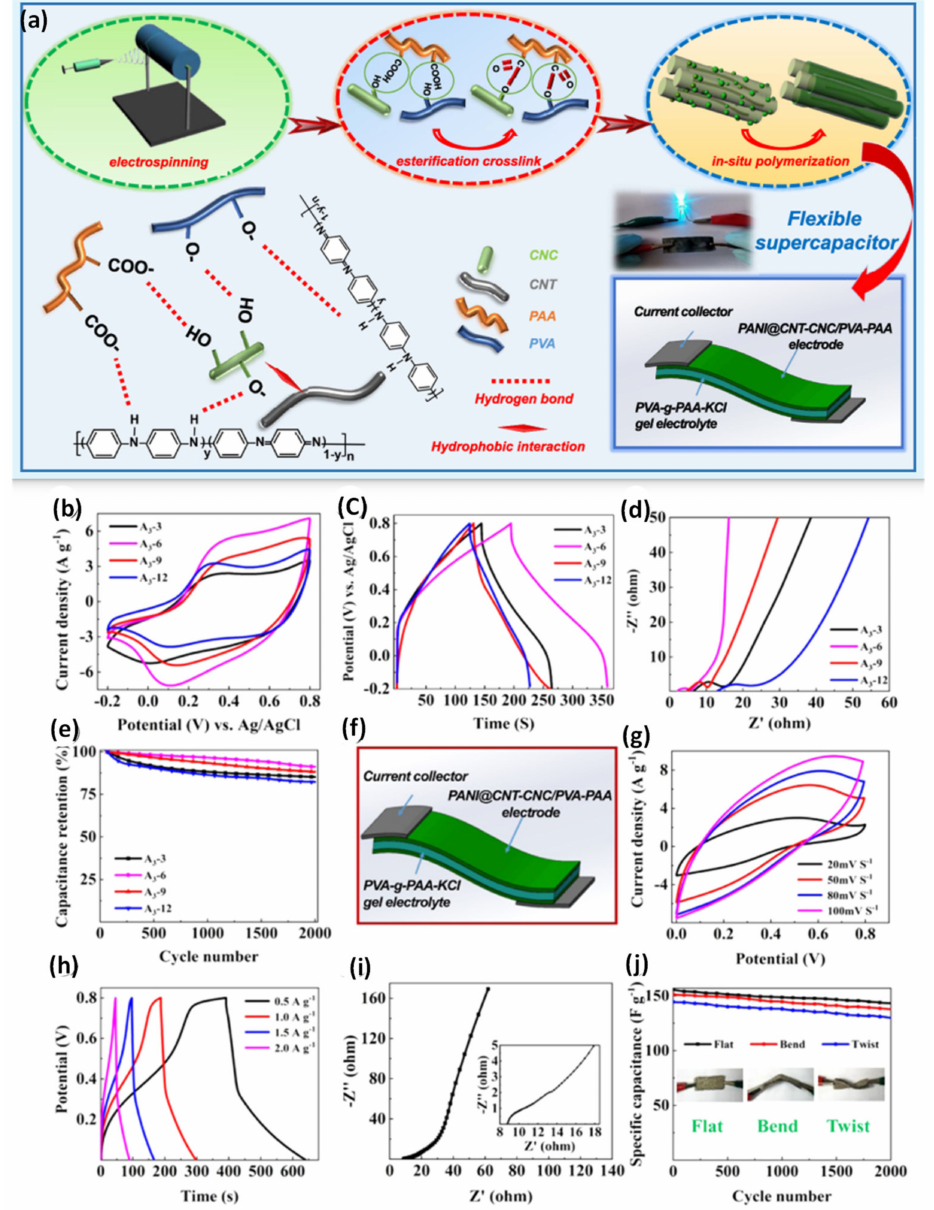
Figure 9. ( a ) The preparation PANI@ CNT − CNC/PVA − PAA; the electrochemical performance of the core-shell-structured PANI@CNT − CNC/PVA − PAA nanofibrous electrodes. ( b ) CV curves, ( c ) GCD curves, ( d ) EIS analysis and ( e ) cycling life of PANI@CNT − CNC/PVA − PAA. ( f ) The sym- metrical flexible supercapacitor. ( g ) CV curves, ( h ) GCD curves, ( i ) Nyquist plots and ( j ) cycling life of the symmetrical PANI@ CNT − CNC/PVA − PAA flexible supercapacitor. Adapted with permission from [110]. Copyright 2019 American Chemical Society